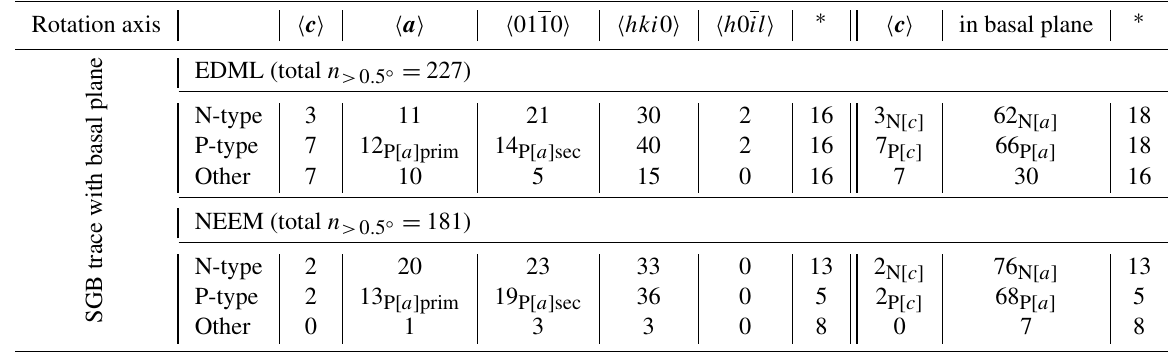
c a is 0001 , is 1210 , (cid:104) (cid:105) (cid:104) (cid:105) (cid:104) (cid:105) (cid:104) (cid:105)